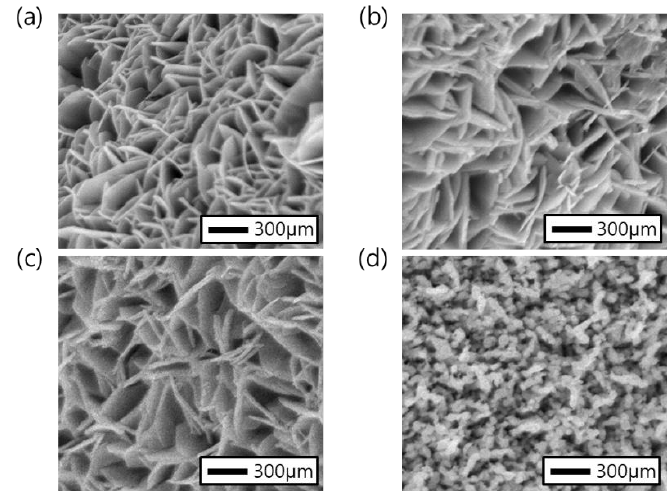
Figure 3. SEM images showing the changes in CCO morphology with temperature: ( a ) 150, ( b ) 200, ( c ) 250, and ( d ) 300 °C, respectively.